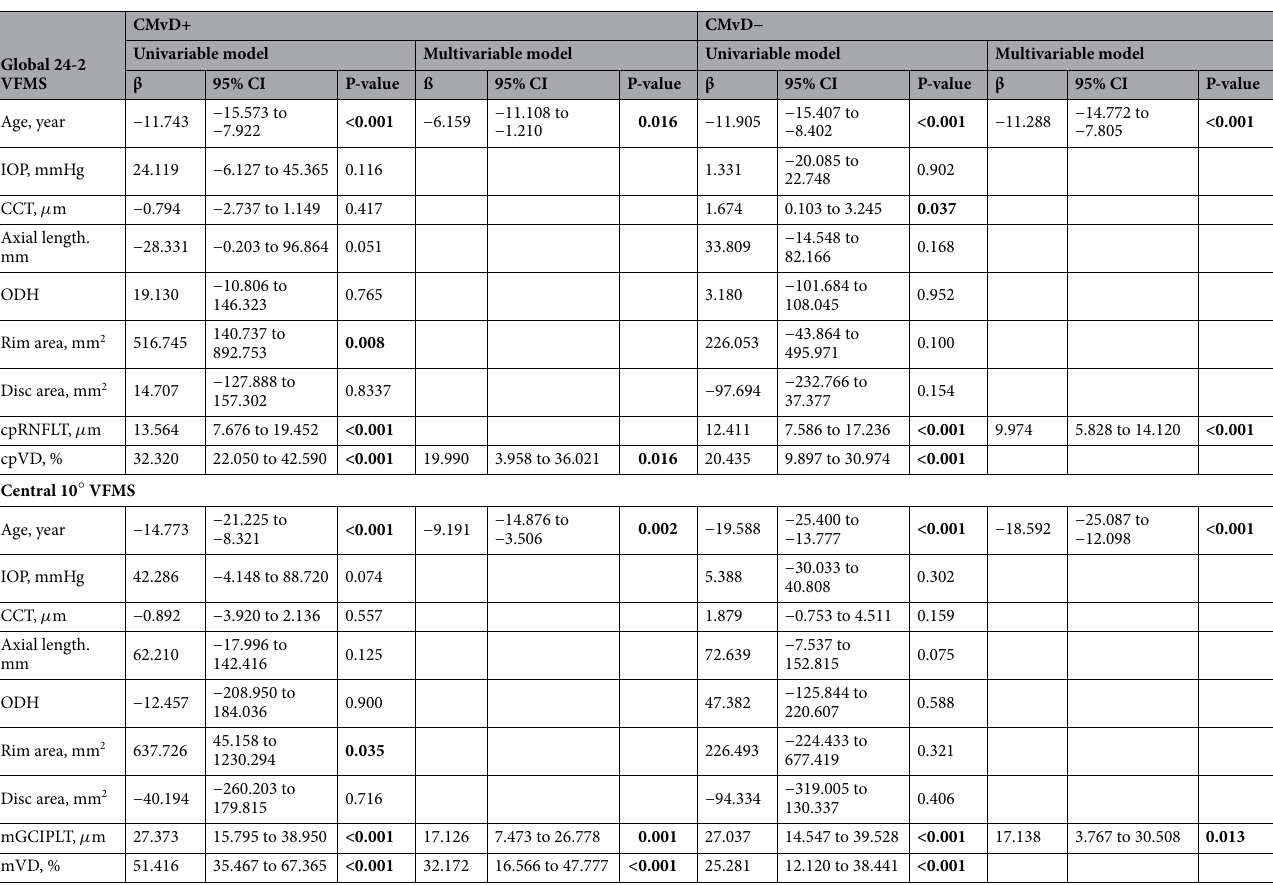
Table 4. Univariate and multivariate linear regression analyses to determine the clinical variables associated ◦ with global 24–2 and central 10 visual field mean sensitivity in open-angle glaucoma eyes with and